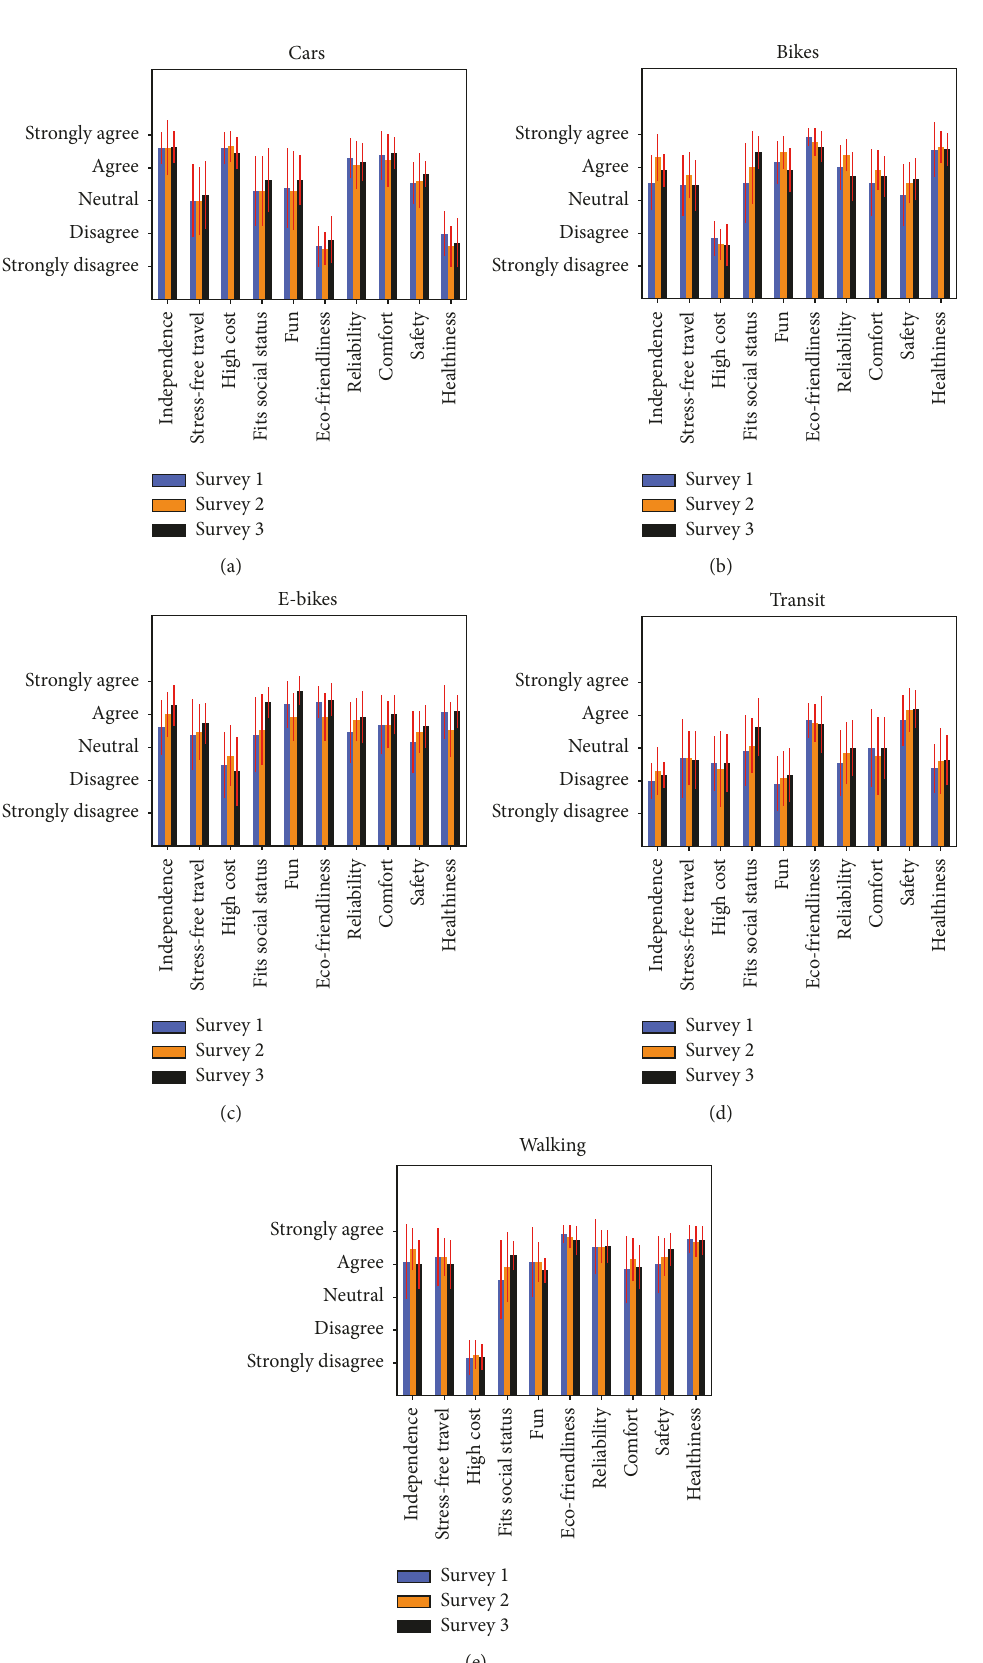
Figure 9: Evaluation of multiple modes of transportation on 10 different aspects across three surveys. For every survey, the mean responses including red error bars are